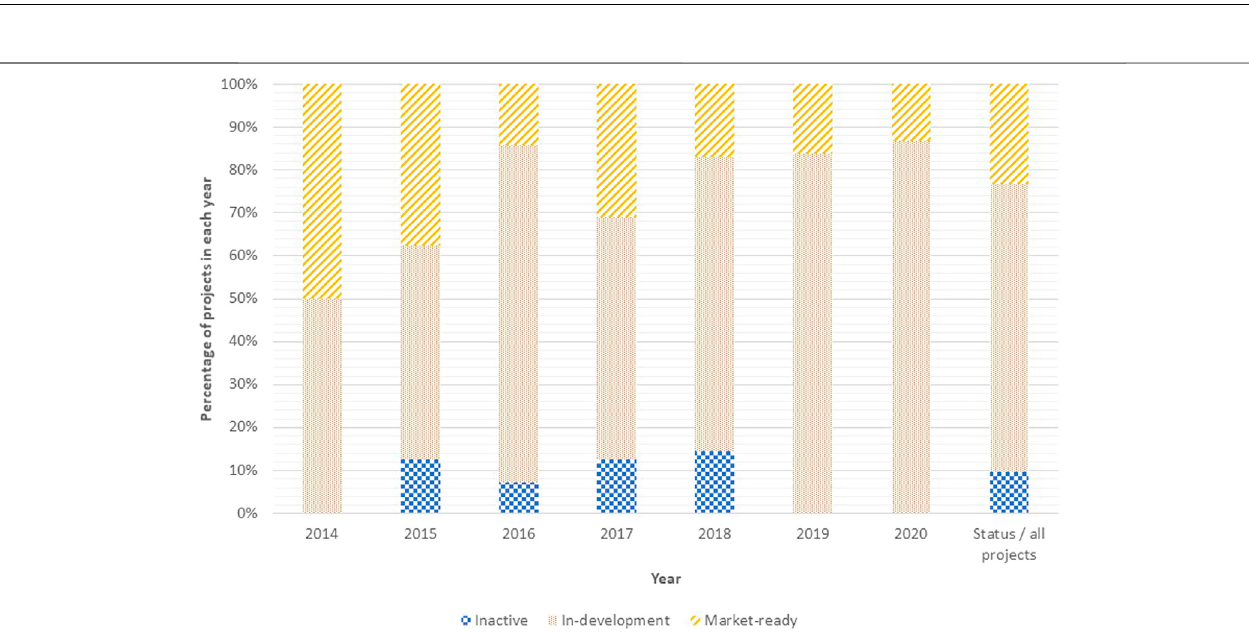
FIGURE 3 | The percentage of projects at various stages based on the project ’ s year of creation.